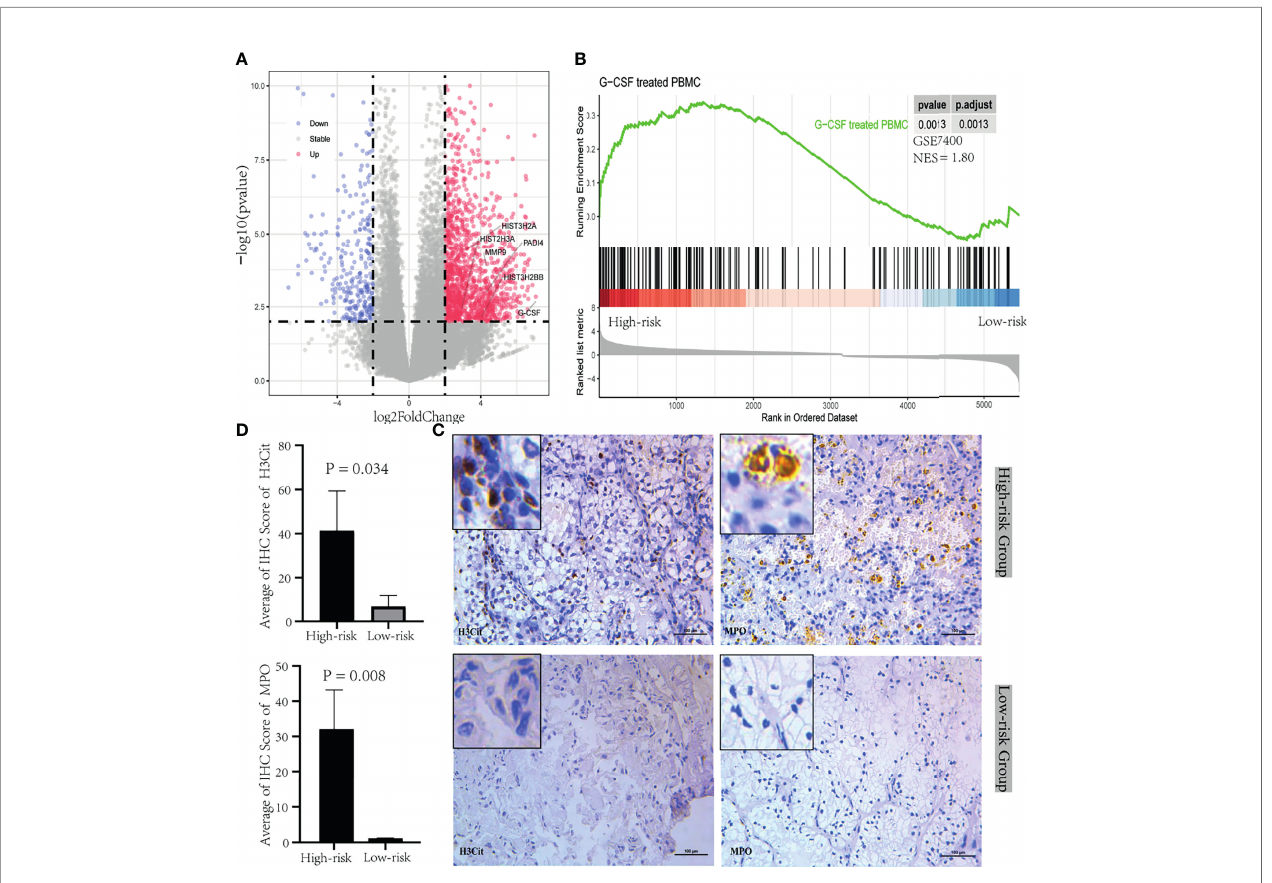
FIGURE 2 | NETosis induced by tumor-derived G-CSF in tumor thrombus of RCC. (A) Volcano plot of the upregulated (red) and downregulated (blue) genes between the group between “ High-risk ” and “ Low-risk ” of tumor thrombus. G-CSF and NETs-associated marker genes including Histone family, PADI4, and MMP9, were signi fi cantly overexpressed in the “ High-risk ” group. (B) GSEA plot of the enriched hallmark gene sets derived from GSE7400 was performed with DEGs between “ High-risk ” and “ Low-risk ” group of PBMC. (C) IHC was performed in tumor thrombus specimens. H3Cit and MPO were stained during NETosis. (D) The bar plot of the IHC score quanti fi cation for H3Cit and MPO between the “ High-risk ” group and “ Low-risk ” group. Data were expressed as mean ±